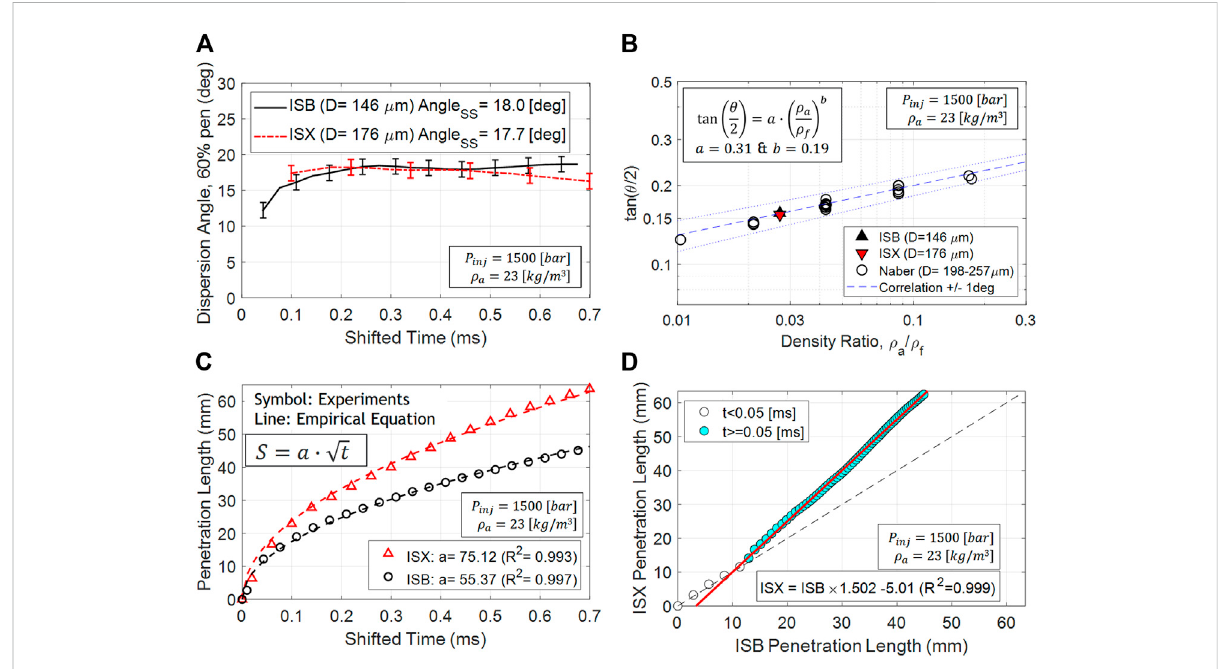
FIGURE 9 (A) Comparisonindispersionangle(60%pen)betweentheISXandISBinjectorswheresubscriptSSindicatesquasi-steadystate. (B) Comparison withprevious studies(NaberandSiebers,1996)where ρ f isthefueldensity. (C) Comparison ofthespraypenetrationlengthsbetweentheISB andISX injectors(symbols)with fi ttedsquare-rootcorrelations(dashedlines). (D)